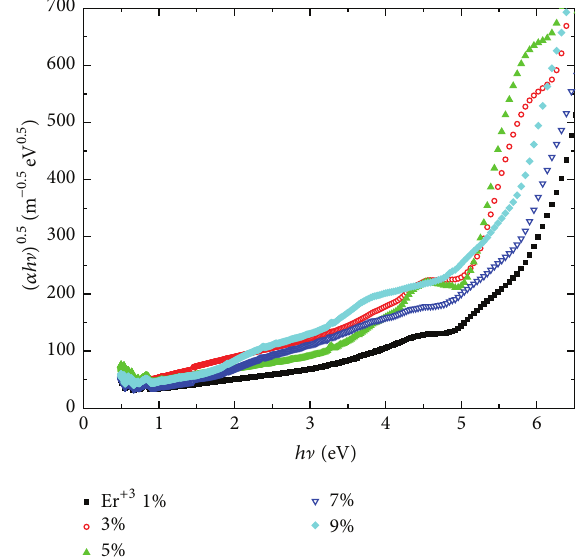
Figure 6: The plot of ( 𝛼ℎ ] ) 0.5 versus ℎ ] for PVA: ErCl 3